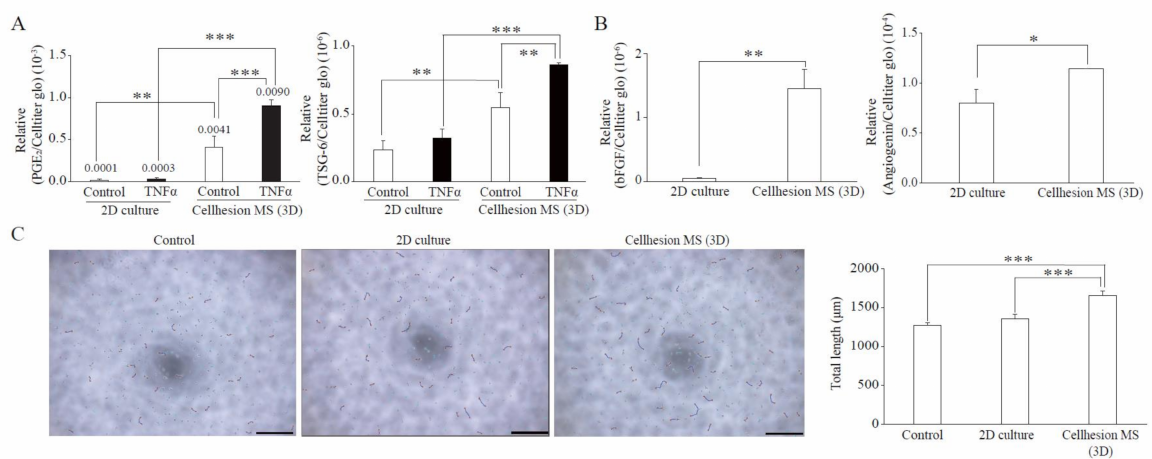
Figure 2. Paracrine factors from UCMSCs with Cellhesion ® MS. ( A ) The secretion levels of PGE 2 and TSG-6 by UCMSCs cultured with Cellhesion ® MS increased, compared with monolayer culture. The secretion levels of PGE 2 and TSG-6 by UCMSCs were measured by ELISA and normalized with an ATP assay. ** p < 0.01, *** p < 0.001, compared with each control or TNF α . ( B ) The secretion levels of bFGF and Angiogenin by UCMSCs cultured with Cellhesion ® MS increased, compared with monolayer culture. The secretion levels of bFGF, and Angiogenin by UCMSCs were measured by ELISA and normalized with an ATP assay. * p < 0.05, ** p < 0.01, compared with each culture. ( C ) The total length of HUVEC treated with CM from UCMSCs with Cellhesion ® MS was significantly longer than control and with CM from monolayer cultured UCMSCs. Total length of HUVEC in each condition was calculated by Angiogenesis Analyzer plug-in on ImageJ software. Each picture was one of the analyzed examples. Scale bar = 500 µ m. *** p < 0.001, compared with control or CM from monolayer cultured UCMSCs. Data show mean averages ± SD for three independent